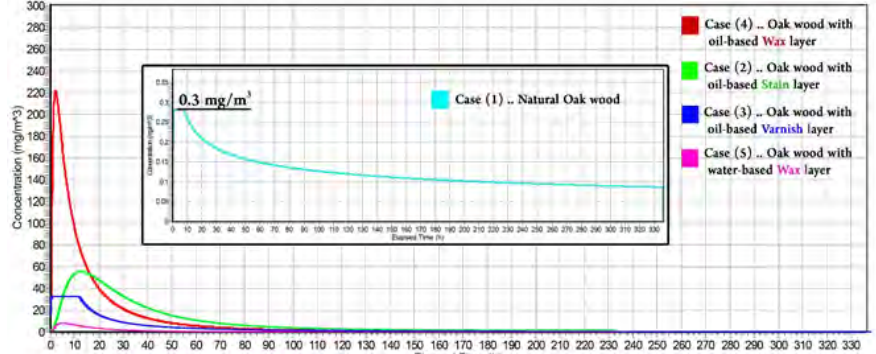
Figure 7. The analysis of TVOC concentrations of the Cases v.s elapsed